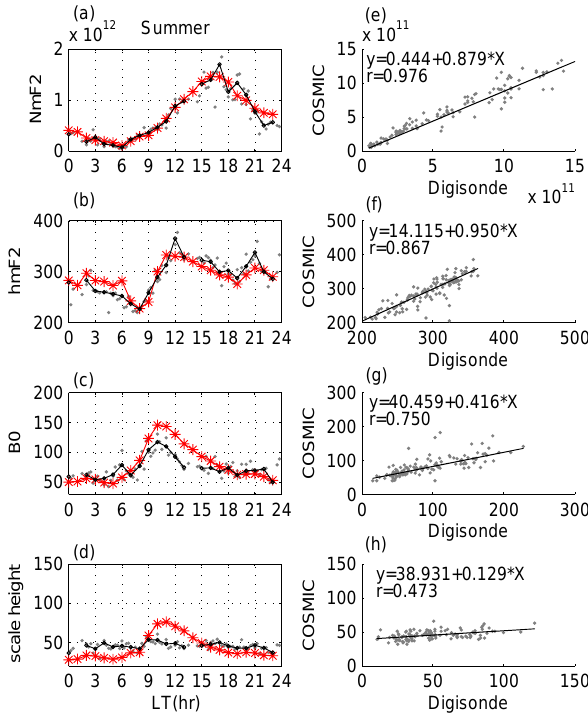
Fig. 3. (a) – (d) Comparison of the diurnal variations obtained from ground-based observations (red asterisk) and RO measurements (circled line) and (e) – (h) scatter plots for the Nm F2, hm F2, B 0, and H T parameter in the equinox period.